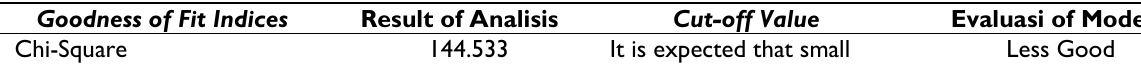
Table 3. Evaluation of Goodness of Fit Goodness of Fit Indices Result of Analisis Cut-off Value Evaluasi of Model Chi-Square 144.533 It is expected that small Less